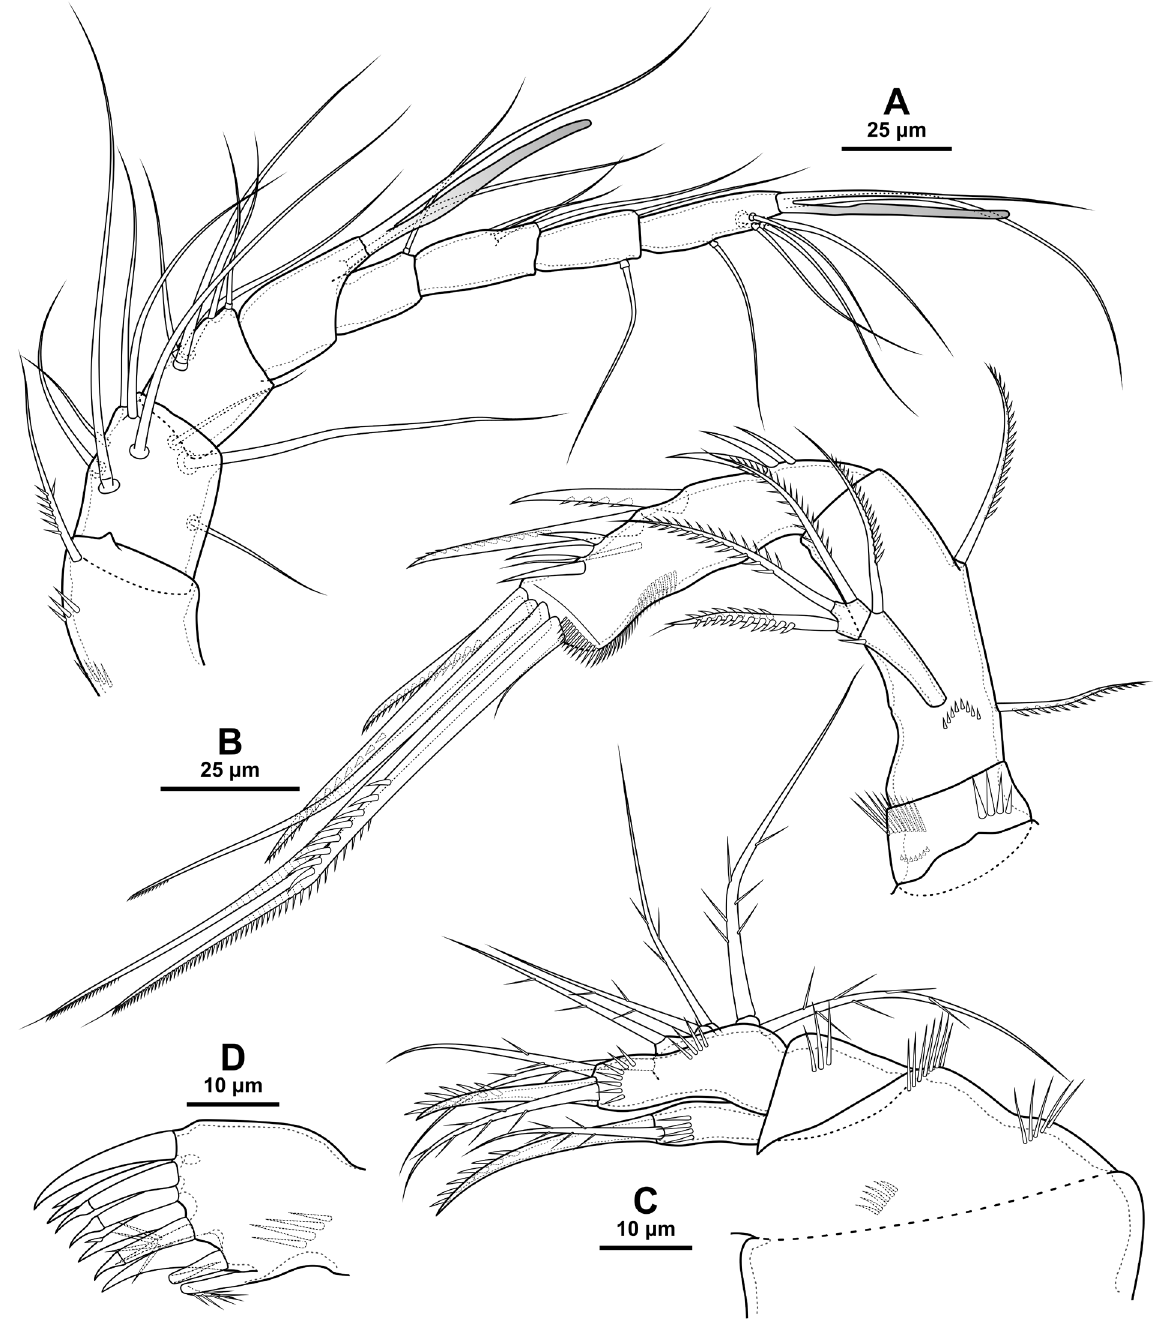
Fig. 4. Canthocamptus waldemarschneideri sp. nov., holotype, ♀ (KFU BP 544/1). A . Antennule. B . Antenna. C . Maxillule, without arthrite. D . Maxillule,